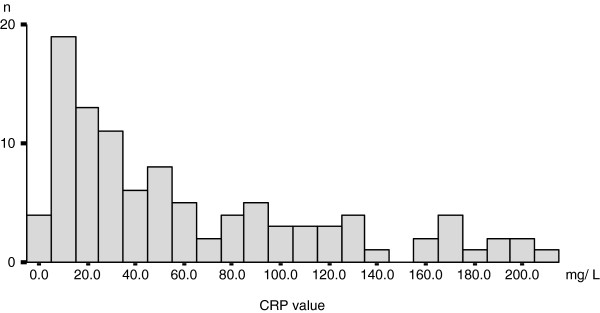
Histogram of elevated CRP value in patients with AM-RCC. Among 143 patients with AM-RCC, 103 (72.0%) exhibited abnormal CRP values (>3.00 mg/L) at initial presentation; the graph was plotted for these values.